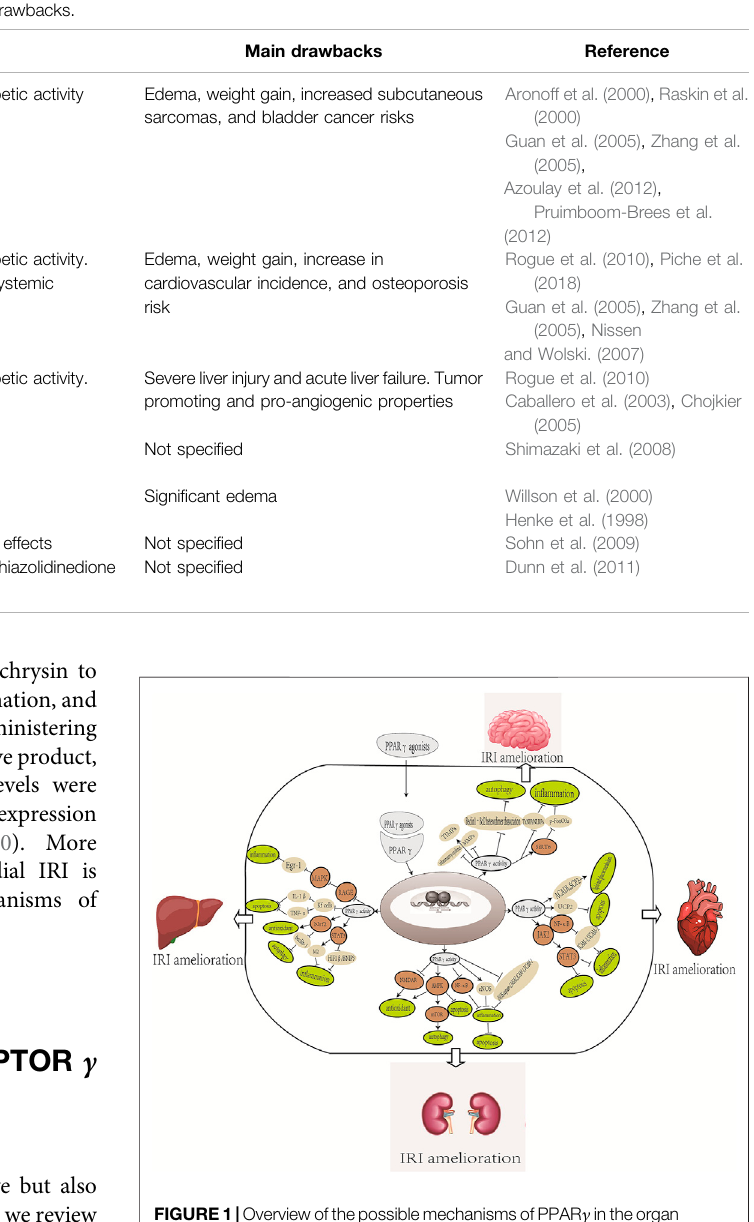
FIGURE1| OverviewofthepossiblemechanismsofPPAR γ intheorgan IRI. The mechanism includes different effects of different PPAR γ agonists. NMDA, N-methyl-D-aspartic acid; eNOS, endothelial NO synthase; iNOS, inducible NO synthase; Nrf2, nuclear factor-erythroid 2-related factor 2; RAGE, receptor for advanced glycation end products; SIRT6P, the endogenous retinoid X receptor and sirtuin 6; Fox03a; BBB, blood – brain barrier; MMB, matrix metalloproteinase; TIMPs, tissue inhibitor of metalloproteinase; TXNIP, thioredoxin interacting protein; NLRP3, nod-like receptor family, pyrin domain containing 3; SCP2, sterol carrier protein 2; ACADI, long-chain acyl CoA dehydrogenase; UCP2, mitochondrial uncoupling protein